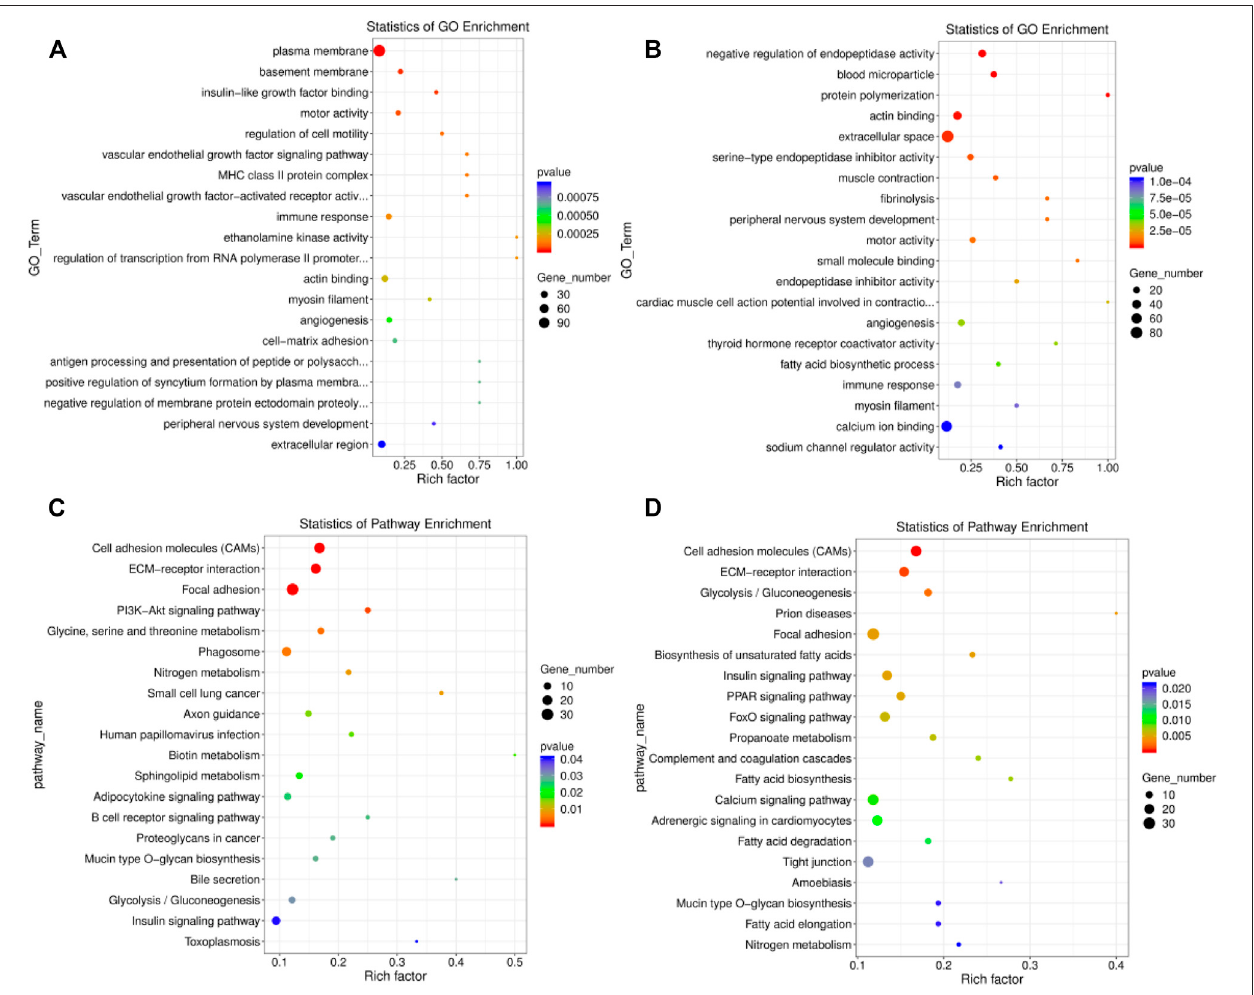
FIGURE4| Top20signi fi cantlyenrichedGOandKEGGpathwaysofthedifferentiallyexpressedgenes. (A) Thetop20signi fi cantGOtermsintheEU vs .HFgroup. (B) Thetop20signi fi cantGOtermsintheSK vs .HFgroup. (C) Thetop20signi fi cantKEGGpathwayintheEU vs .HFgroup. (D) Thetop20signi fi cantKEGGpathwayin the SK vs HF